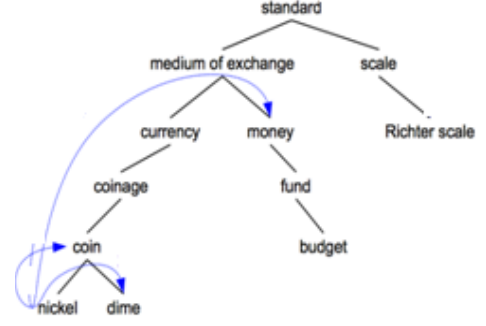
Figure 2. Edge Based Approach presented by Lin